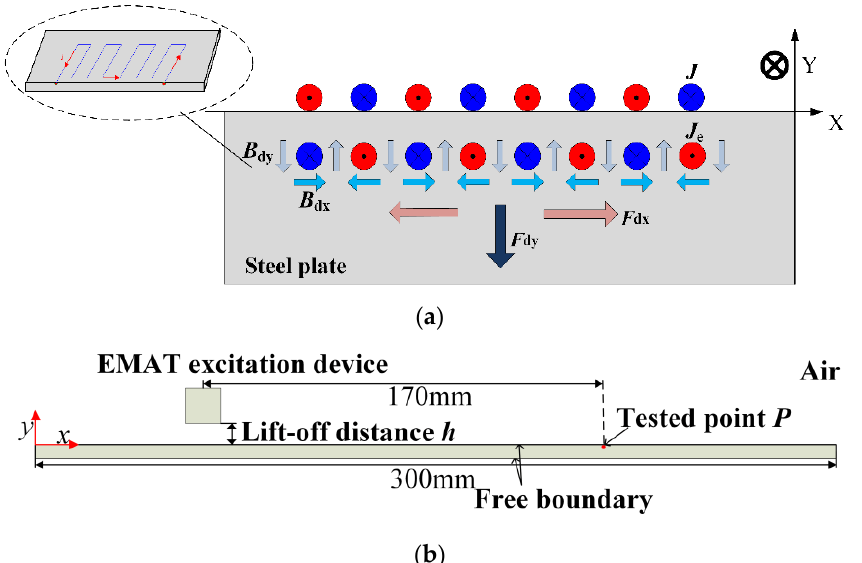
Figure 2. High-energy pulse EMAT. ( a ) Excitation principle of the high-energy pulse EMAT; ( b ) High-energy pulse EMAT finite element simulation model.